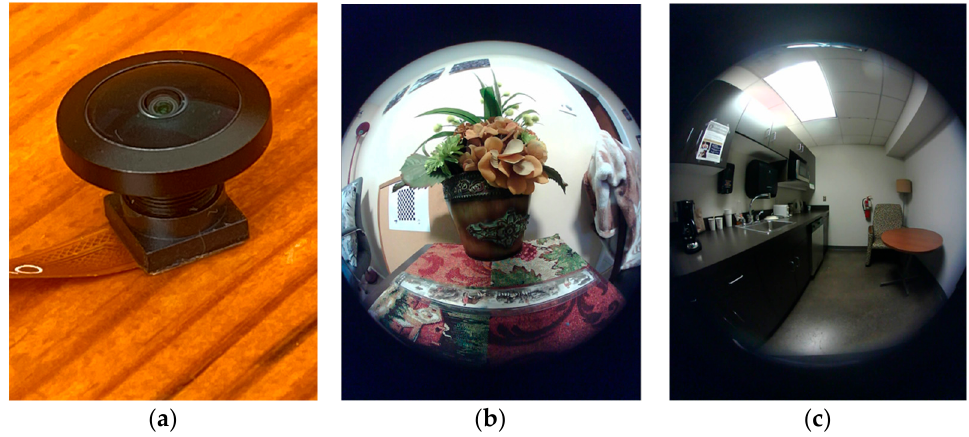
Figure 7. ( a ) Nuoweian fisheye lens, ( b ) and ( c ) raw images obtained by the lens.